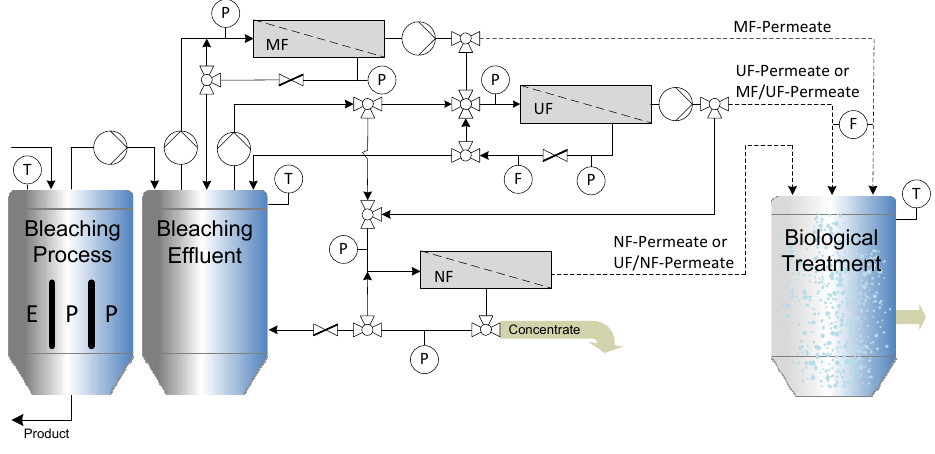
Figure 3. Schematic illustration of the laboratory-scale multi-stage cross-flow filtration